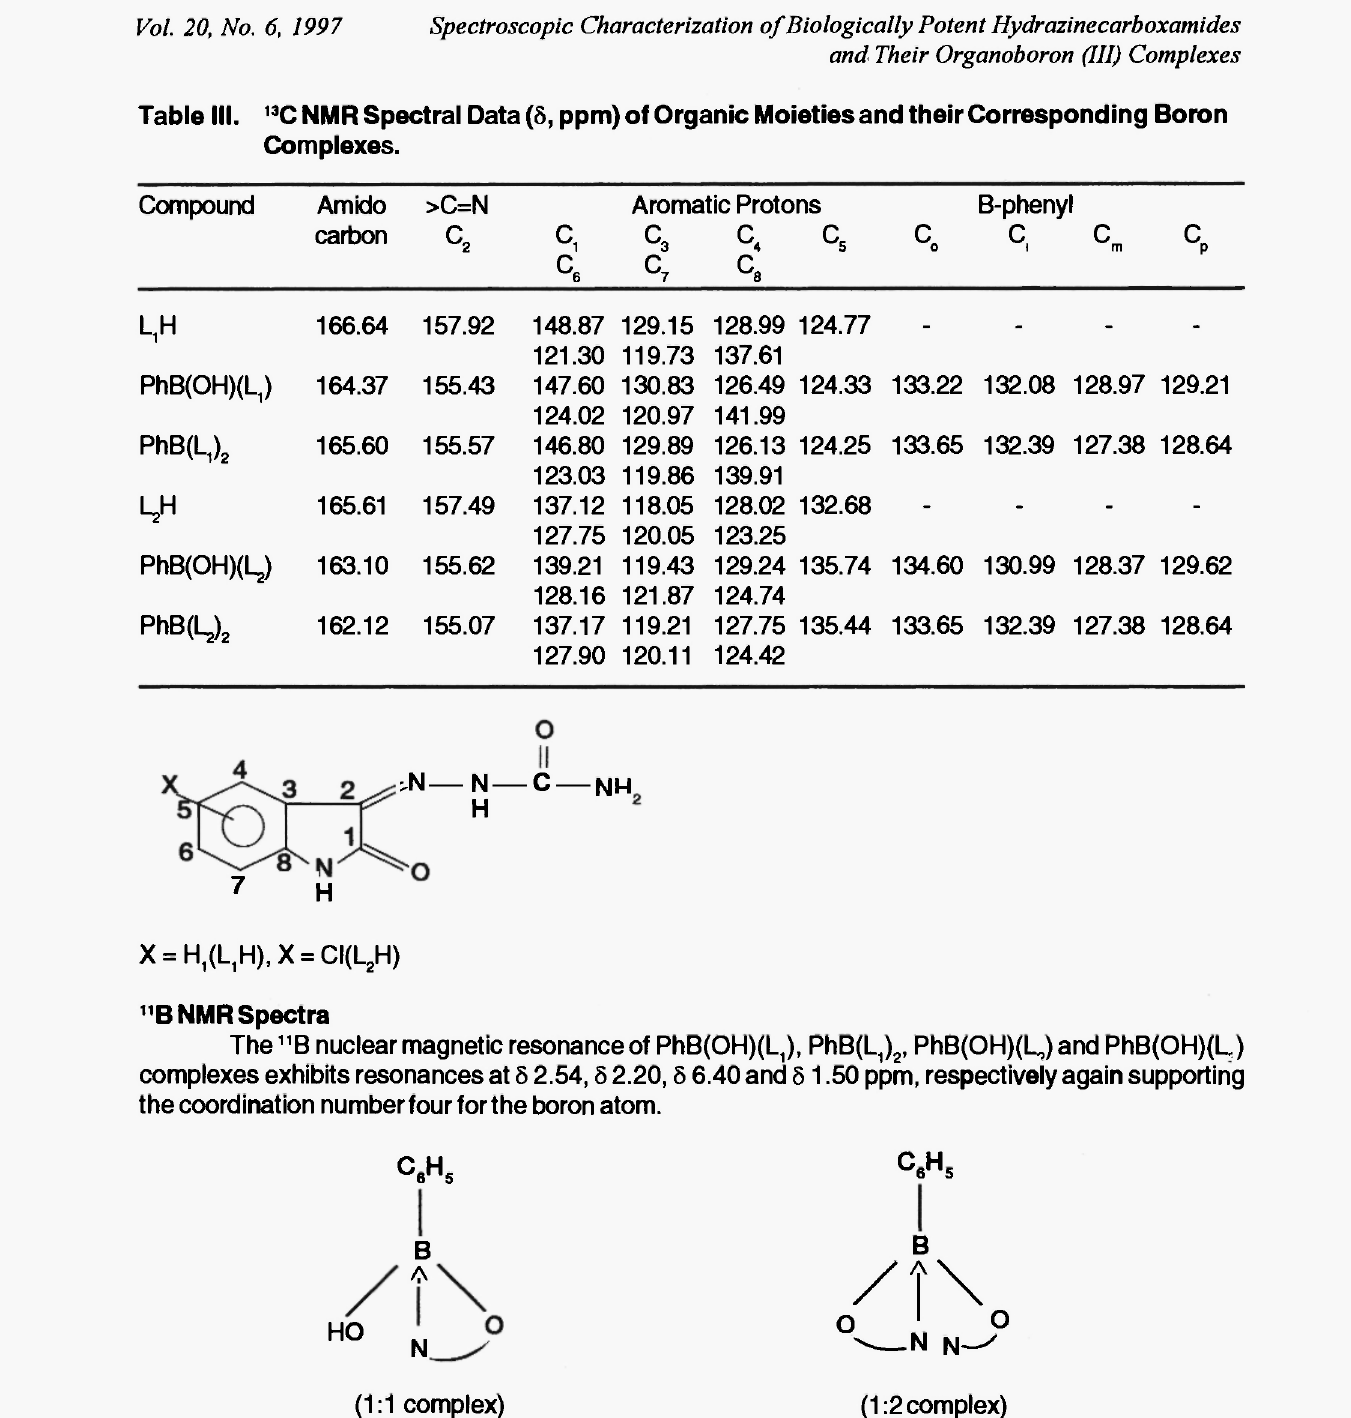
Table III. 13 C NMR Spectral Data (δ, ppm) of Organic Moieties and their Corresponding Boron